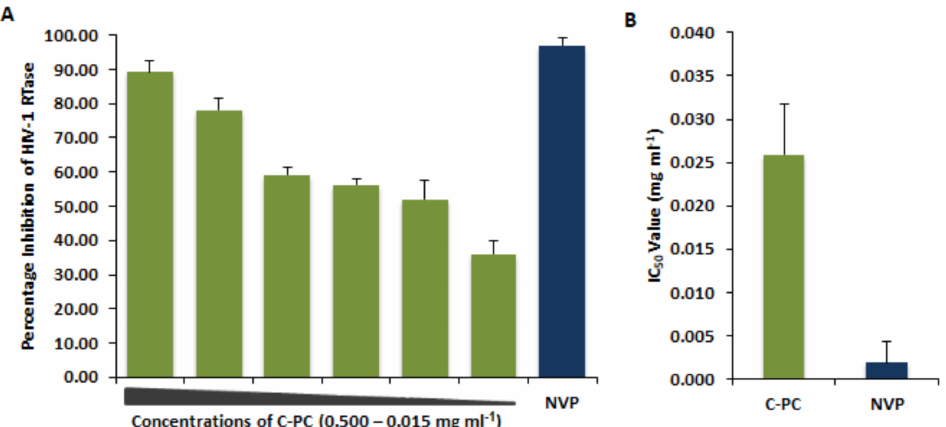
Figure 4. C-PC inhibits HIV-1 viral enzyme Reverse Transcriptase. ( A ) Percentage inhibition of HIV-1 RTase enzyme activity in the presence of C-PC in a dose-dependent (0.50–0.15 mg/mL) assay. A known HIV-1 RT inhibitor NVP (2 µ M) was used as positive control. ( B ) Comparative analysis of IC 50 concentrations of C-PC and NVP on HIV-1 RTase